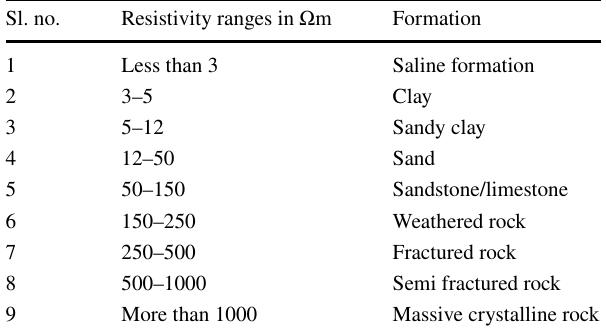
Table 3 Resistivity range of lithological units. ( Source : Arul- prakasam 2010) Sl.